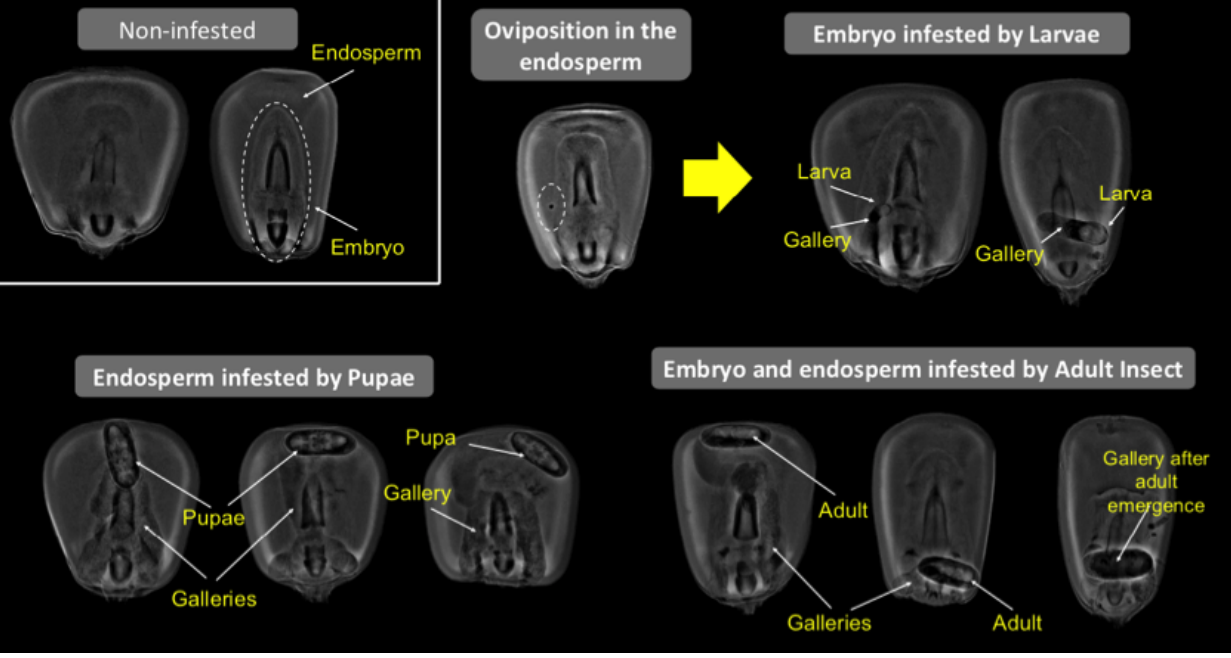
Figure 4. X-ray imagens processed by peripheral equalization and calcification emphasis algorithms for classes of non- infested maize grains and grains infested by Sitophilus zeamais showing damages (“galleries”) in different parts of the grain.